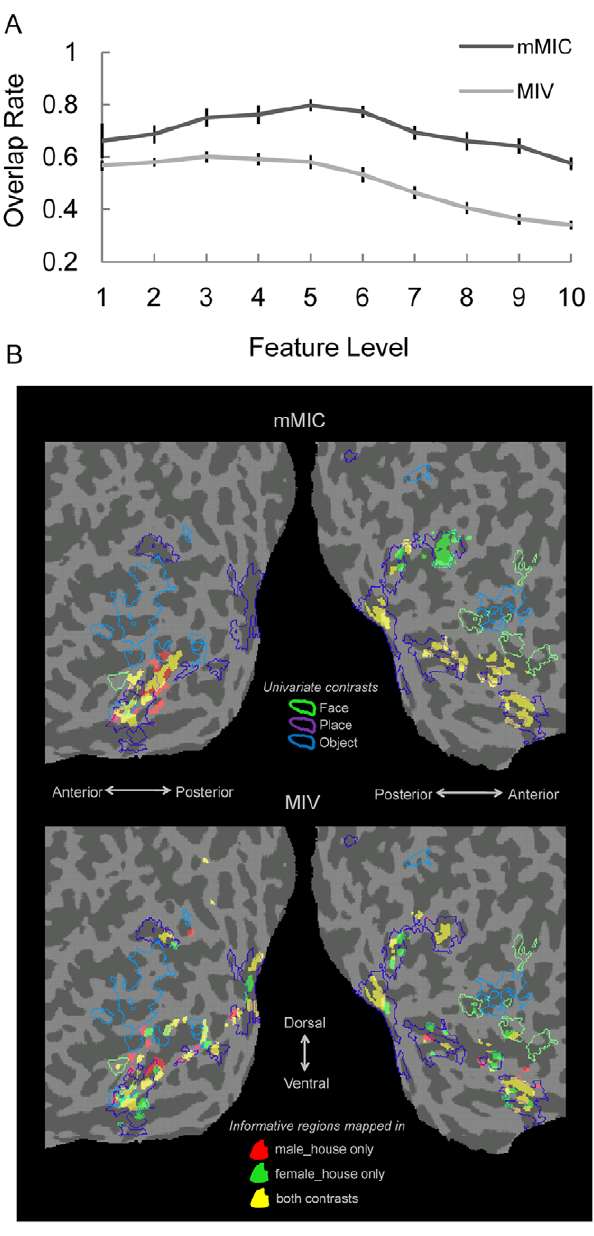
Figure 4. Overlap between informative regions mapped for female and male faces. A) Overlap rate between informative regions mapped in the contrasts of male faces vs. houses and those in the contrast of female faces vs. houses. Error bars indicate standard error of mean across subjects. B) Distribution of the overlap between informative regions for female and male faces by the mMIC and the MIV respectively. The size of regions was chosen to match the feature level at which the best prediction performance was achieved, which was set to the same for both methods and in both contrasts. For comparison, face-, place- and object-selective regions localized by the univariate analysis (p , 10 2 6 , uncorrected) were shown in colored contours as a